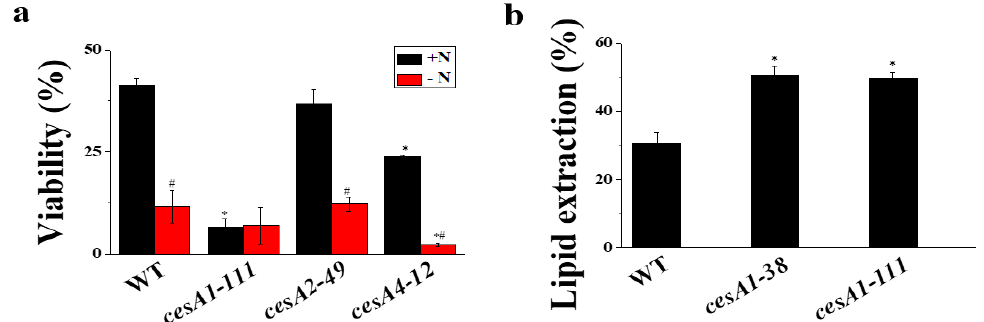
Figure 5. Cell viability after sonication mechanical stress ( a ) and lipid extraction e ffi ciency ( b ) for wild-type (WT) and cesA mutants grown under + N ( a , b ) and − N ( a ) conditions for 3 d. In ( b ), the lipid extraction e ffi ciency was calculated by dividing the amount of lipids extracted by sonication by total lipid content. Each data point represents the mean ± SE of three biological replicates performed in triplicate. The symbols represent statistically significant di ff erences ( p ≤ 0.05) between mutants vs. WT (*), and between + N and − N cells (#),